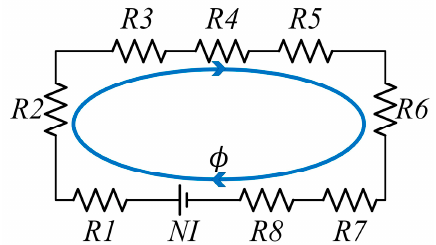
Figure 5. Axial single-coil configuration equivalent magnetic circuit model.